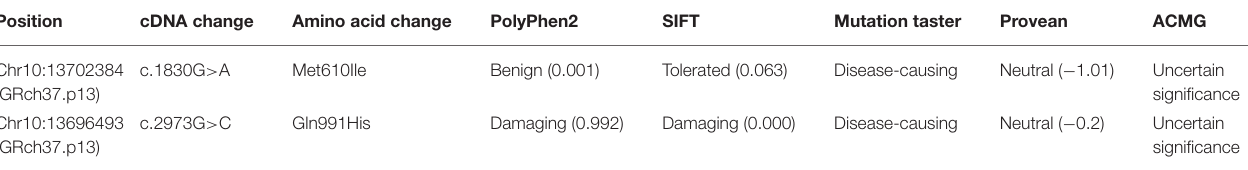
TABLE 1 | Molecular information of compound heterozygous mutation on chromosome 10 of FRMD4A family. Position